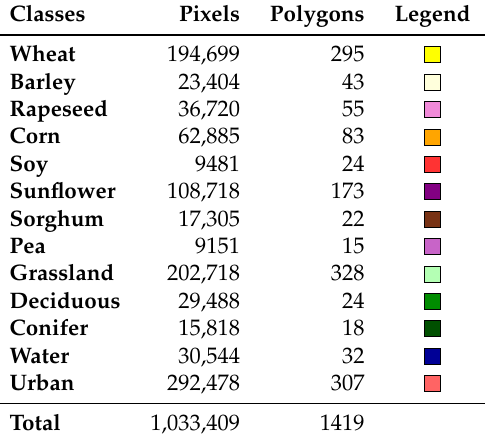
Table 1. Number of instances per class counted at pixel- and polygon-level. Classes Pixels Polygons